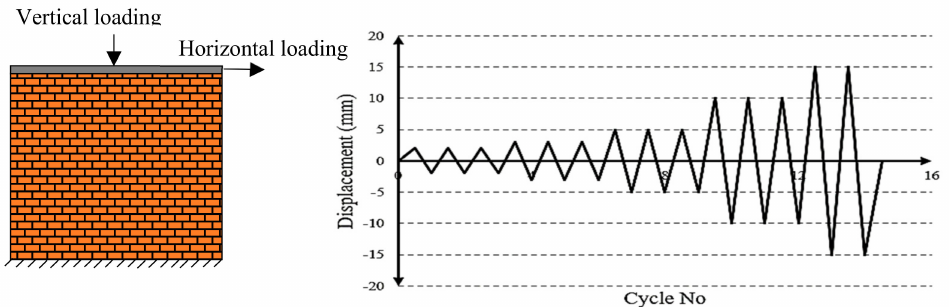
Figure 5. The protocol of the applied lateral displacement, adapted from